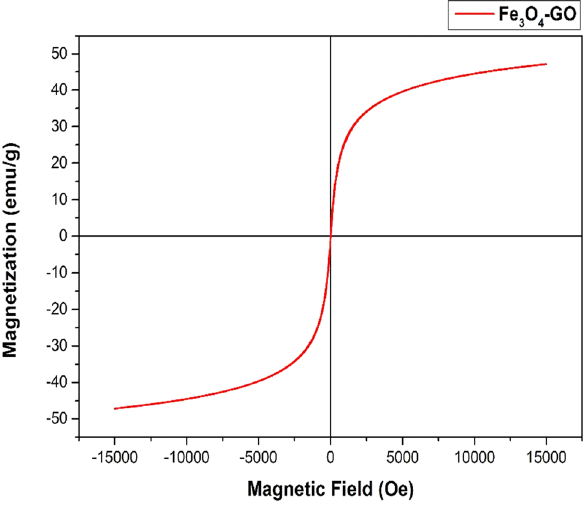
Figure 3: Magnetization curves of GO and Fe 3 O 4 @GO.